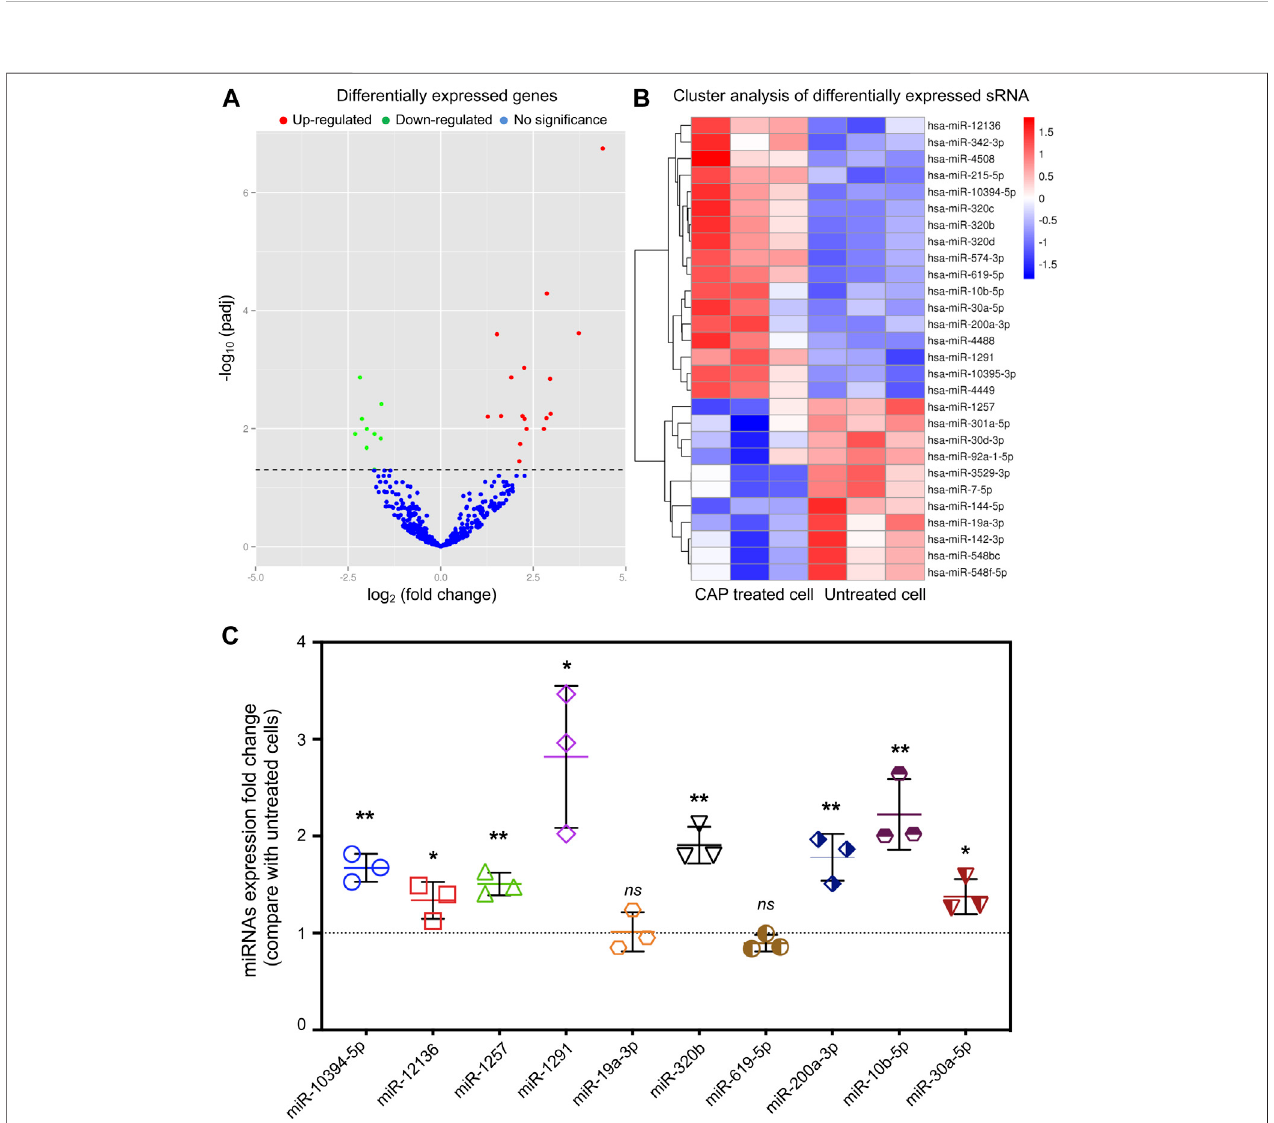
FIGURE4 | Volcano plot and heat map ofdifferentially expressed miRNAsobtained from the comparison ofCAP-treated and untreatedK562 cells. (A) Each point inthevolcanoplotrepresentsonemiRNA.Redpointsrepresentupregulatedones,greenpointsrepresentdownregulatedones,andbluepointsrepresentnosigni fi cant changesofmiRNAs. (B) Theabscissarepresentsdifferentgroups,theordinaterepresentsthedifferentmiRNAscomparedinthegroups,andthecolorblocksatdifferent positions represent the relative miRNA expressions. (C) miRNA expression of fold change detected by qRT-PCR in K562 cells after 90 s of CAP treatment ( n = 3, * p < 0.05, ** p < 0.01, ns = no signi fi